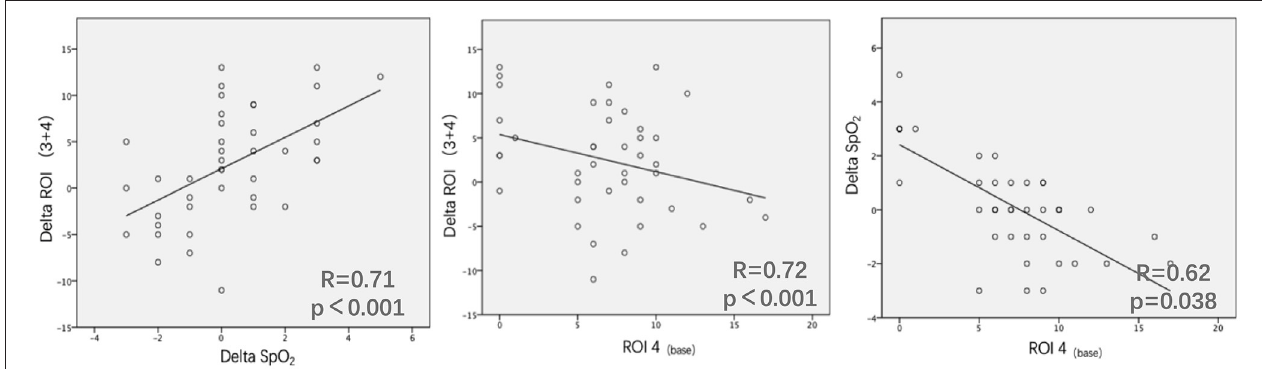
FIGURE 2 | Relationship between 1 ROI 3 + 4 and 1 SpO 2 , ROI 4 (base) and 1 ROI 3 + 4, and ROI 4 (base) and 1 SpO 2 in 41 patients. 1 ROI 3 + 4 means ROI 3 + 4 at T 60min − ROI 3 + 4 at T base . 1 SpO 2 means SpO 2 at T60 min–SpO 2 at T base . ROI 4(base) means ROI 4 at T base . Some data points overlap.